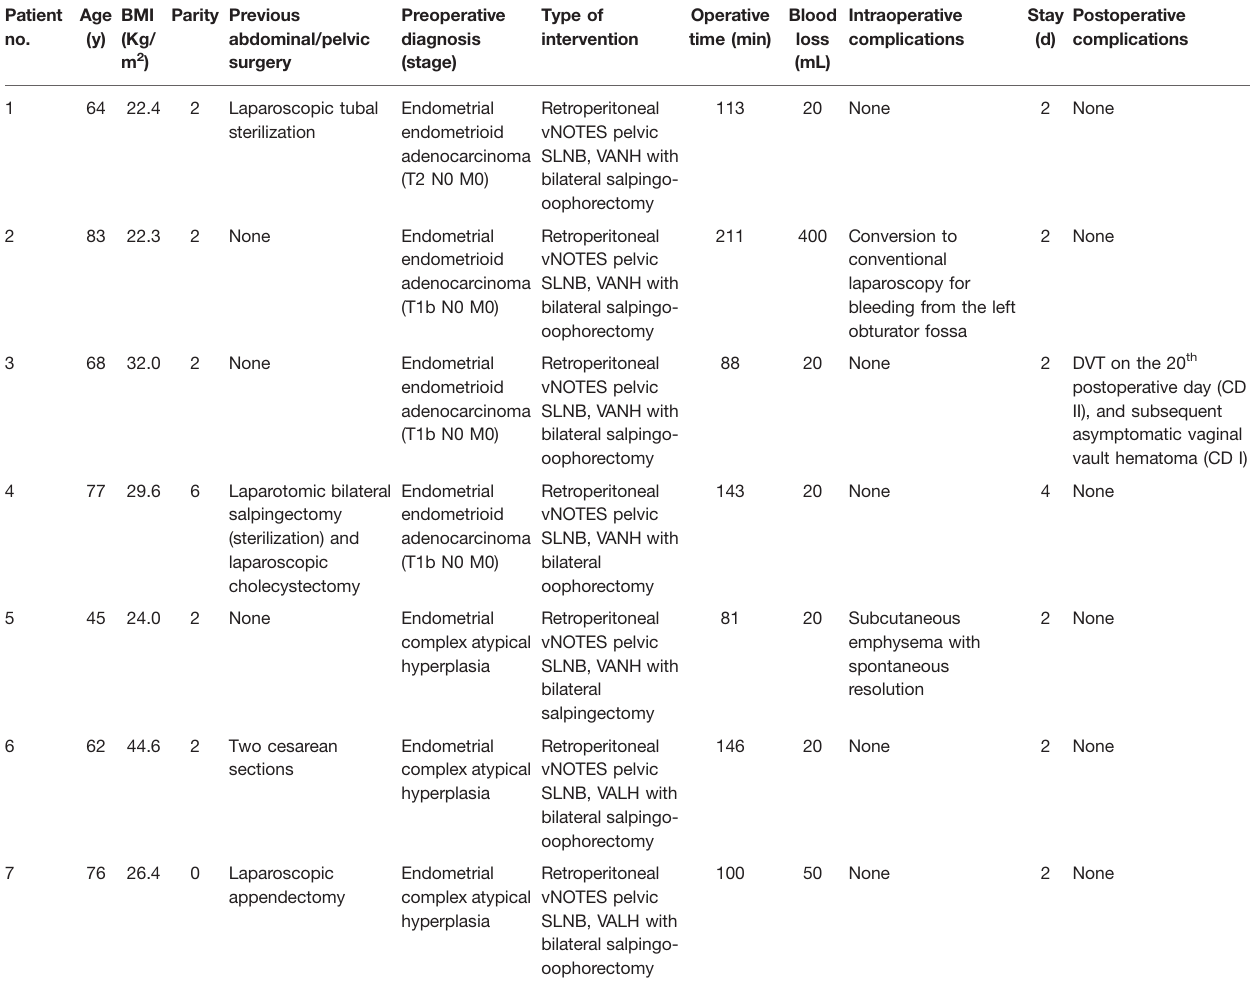
TABLE 1 | Demographics and perioperative characteristics. Patient